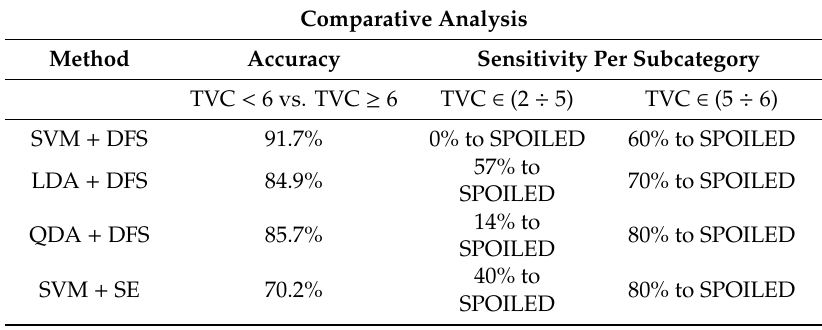
Table 3. Classification results of the comparative analysis. Linear Discriminant analysis (LDA) and Quadratic Discriminant Analysis (QDA) are used instead of SVM with the DFS approach. SVM classifier is then used with standard SE feature selection approach. Accuracy values are listed together with a broad report of the sensitivity values for each subcategory of TVC (2,5) and